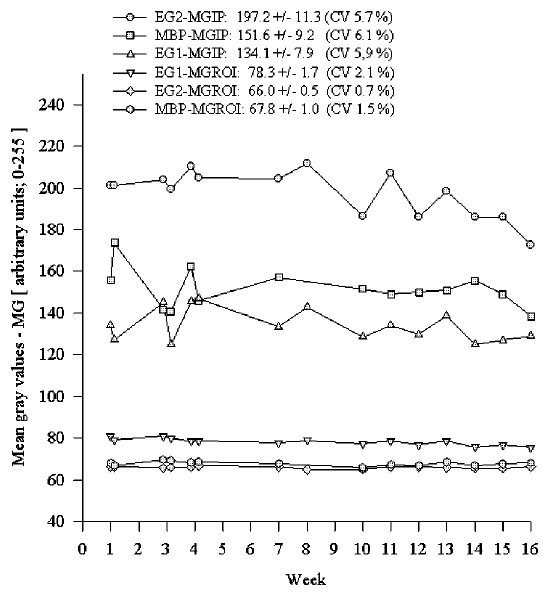
Fig. 3. VARTOTAL-MG: Mean grey values (MG) in 44 sequential sections immunostained with the antibodies EG1 ( n = 15), EG2 ( n = 15) or MBP ( n = 14) within a 16-week period. (MGIP: MG of the immunopositive particles; MGROI: MG of the total area. Values in the legend: Mean of all measurements (cid:6) SD, CV = coefficient of variation).